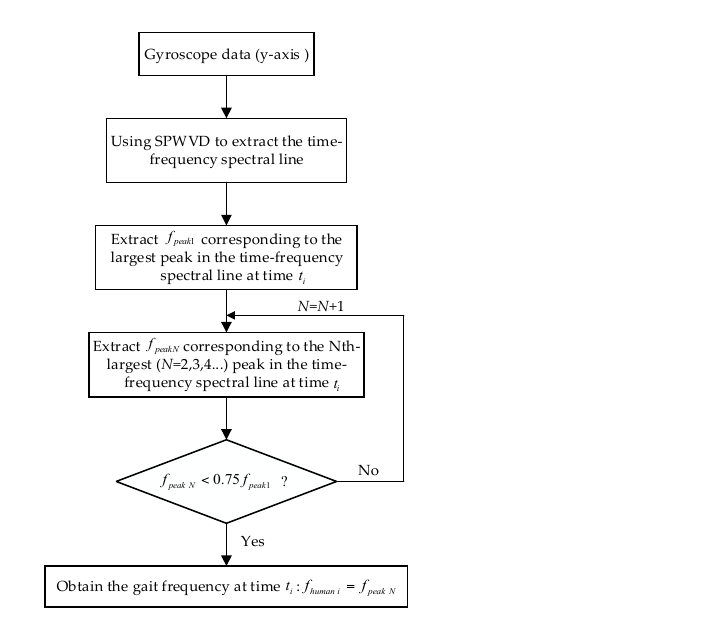
Figure 7. Principle diagram of the time-frequency extraction method based on SPWVD-RMFI. According to the above description, the principle of the time-frequency extraction method based on SPWVD-RMFI can be shown by the flow chart in Figure 8.